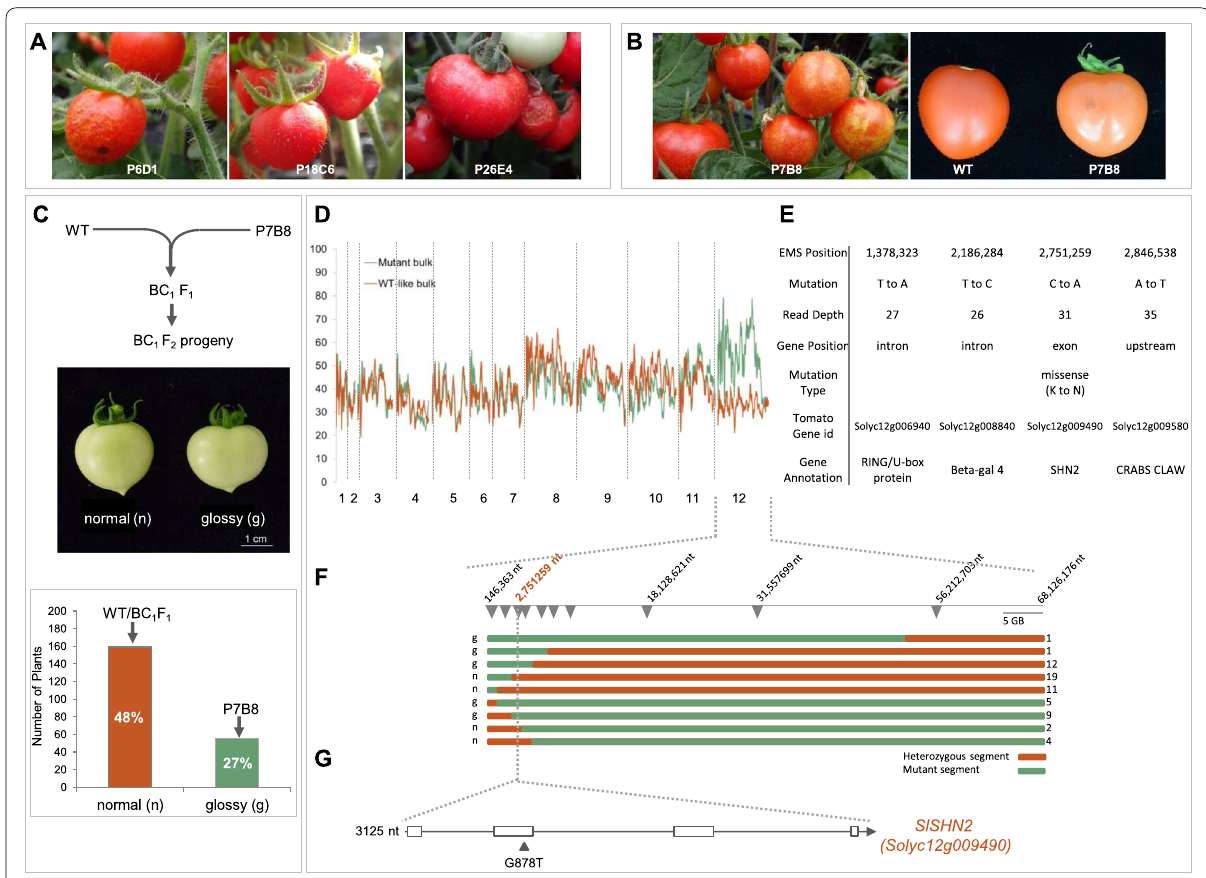
Fig. 1 Mapping-by-sequencing identification of the shn2 mutation responsible for the glossy fruit phenotype. A Examples of fruit cuticle alterations from three independent mutant families. B diversity of micro-cracks, glossiness and colour of red ripe fruits from P7B8 cuticle mutant. C The wild-type (WT) parental line was crossed with the P7B8 glossy mutant. The BC1F2 progeny (216 plants) was screened for glossy fruits (approximately 25% of the plants) and WT-like fruits (approximately 75% of the plants) to constitute the WT-like and the glossy bulks (38 individuals each). D Allelic frequencies (y axis) of glossy and WT-like bulks are represented along tomato chromosomes (x axis) by green and orange lines, respectively. A sliding window of 10 SNPs was used. E, High scoring mutations identified on chromosome 12. Only one mutation (position 2,751,259 on chromosome 12) located in exonic region has a possible deleterious effect on the protein. F Fine mapping of the causal mutation using the BC 1 F 2 population. Recombinant analysis of 768 BC 1 F 2 individuals allowed us to locate the causal mutation at position 2,751,259 nucleotides on SL3.0 Heinz 1706 tomato genome sequence. Marker positions are indicated by grey triangles. Number of recombinants are shown below the position of the markers. Chromosomal constitution of the recombinants are represented by green and orange bars, for mutant and heterozygous segments, respectively. G, the single nucleotide transversion G to T at position 2,751,259 in the second exon of Solyc12g009490 leads to a missense mutation resulting in the K114N amino acid